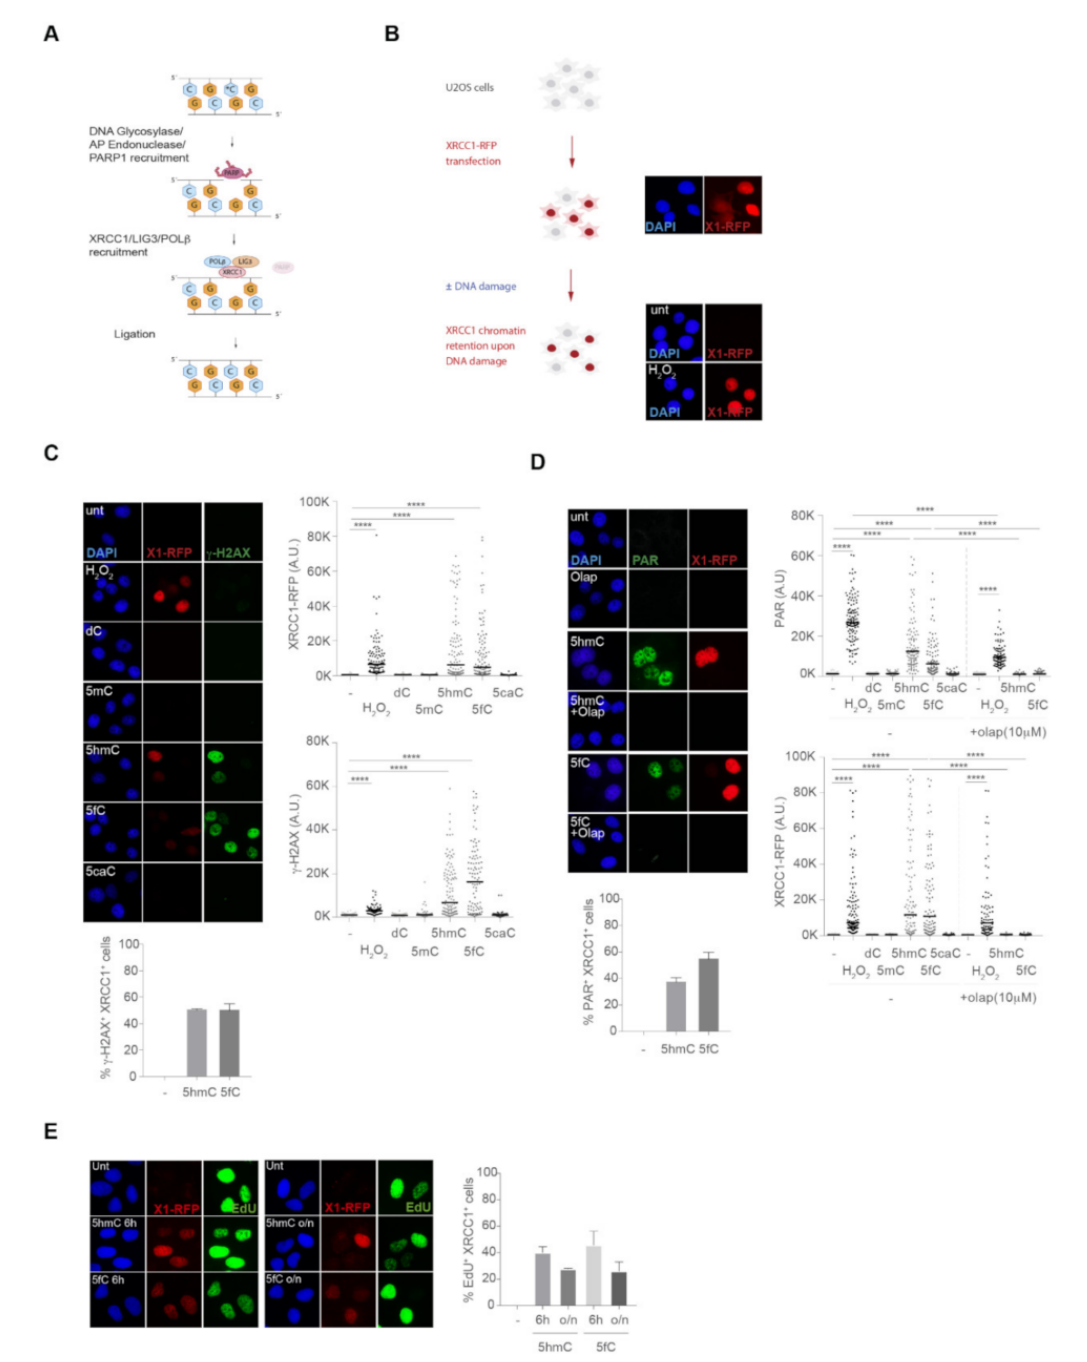
Figure 1. The epigenetically modified DNA bases 5hmC and 5fC activates the BER pathway. ( A ) Representative scheme of BER-SSBR pathway. An epigenetically modified cytosine is recognized by a DNA glycosylase, which creates an abasic site. AP endonuclease 1 (APE1) recognizes and cleaves the sugar-phosphate backbone of the abasic site, generating a single strand break (SSB), which is detected by PARP1. PARP1 acts like a sensor of SSBs and generates poly(ADP-ribose) chains, which interact with the BRCT domain of XRCC1 to promote its recruitment. XRCC1 displaces PARP1 and acts as a scaffold protein for the recruitment of POL β , LIGIII- α , and several end-processing factors (not depicted) to seal the nick present in the broken strand. ( B ) Left, scheme depicting the generation of HsXRCC1-RFP overexpressing U2OS cells and its chromatin retention assay by DNA damage after incubation with H 2 O 2 . Right, representative immunofluorescence images of fixed and